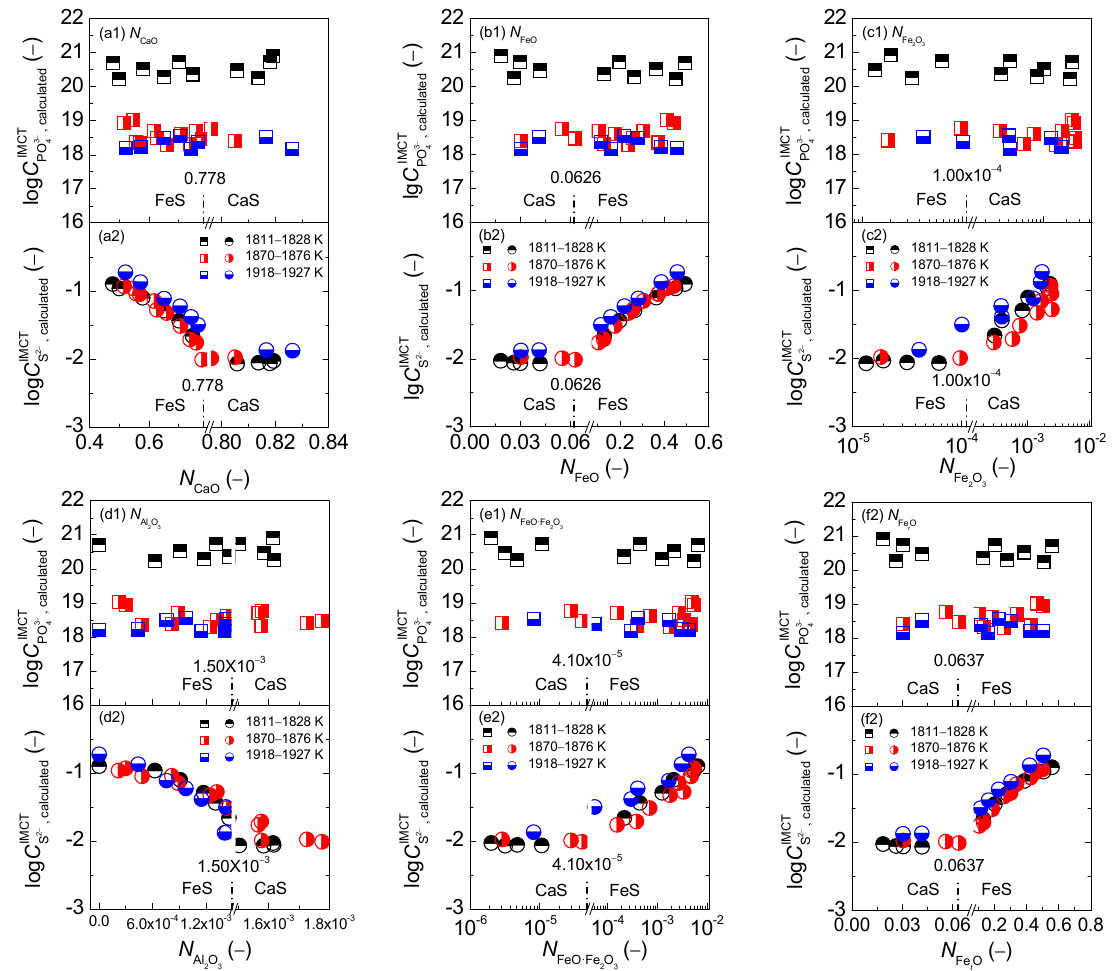
Figure 4. Relationship of calculated [3] mass action concentration N i of CaO ( a ), FeO ( b ), Fe 2 O 3 ( c ), Al 2 O 3 ( d ), FeO · Fe 2 O 3 ( e ), and Fe t O ( f ) against calculated [3] phosphate capacity log C IMCT by the IMCT– C model in the first layer or calculated [5] sulfide capacity log C IMCT IMCT– C model in the second layer for CaO–FeO–Fe 2 O 3 –Al 2 O 3 –P 2 O 5 slags equilibrated with liquid iron over a temperature range of 1811 to 1927 K (1538 to 1654 °C), respectively.